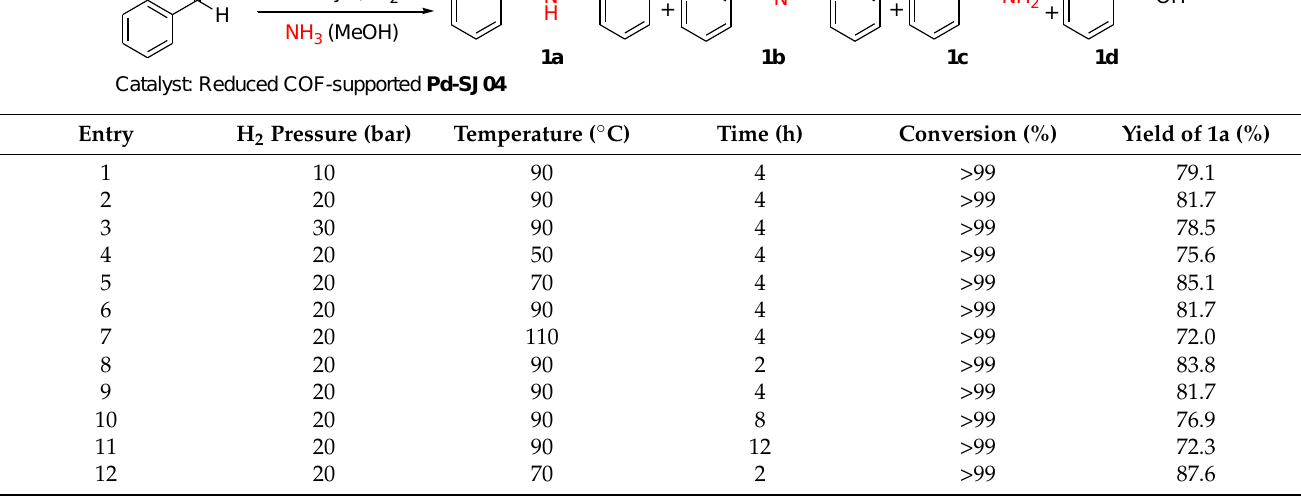
Table 1. Optimizing the conditions for the reductive amination of benzaldehyde to dibenzylamine a